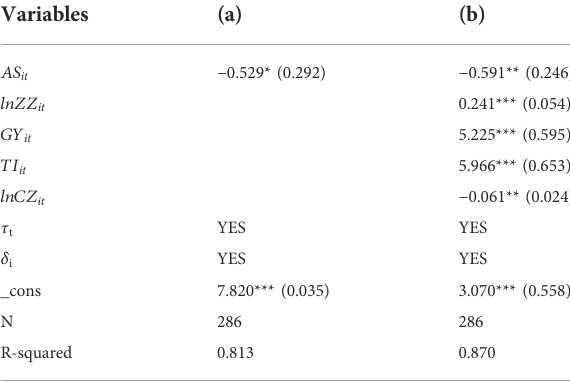
TABLE 5 Effectiveness of socialized agricultural services on agricultural carbon